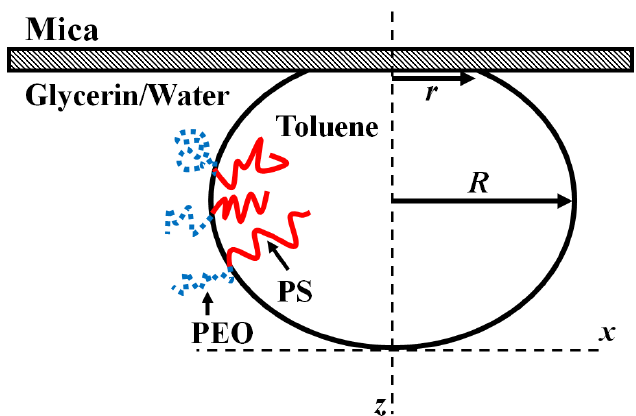
Figure 4. A schematic representation of the PS-PEO covered toluene droplet pushed against a mica sheet by gravity.